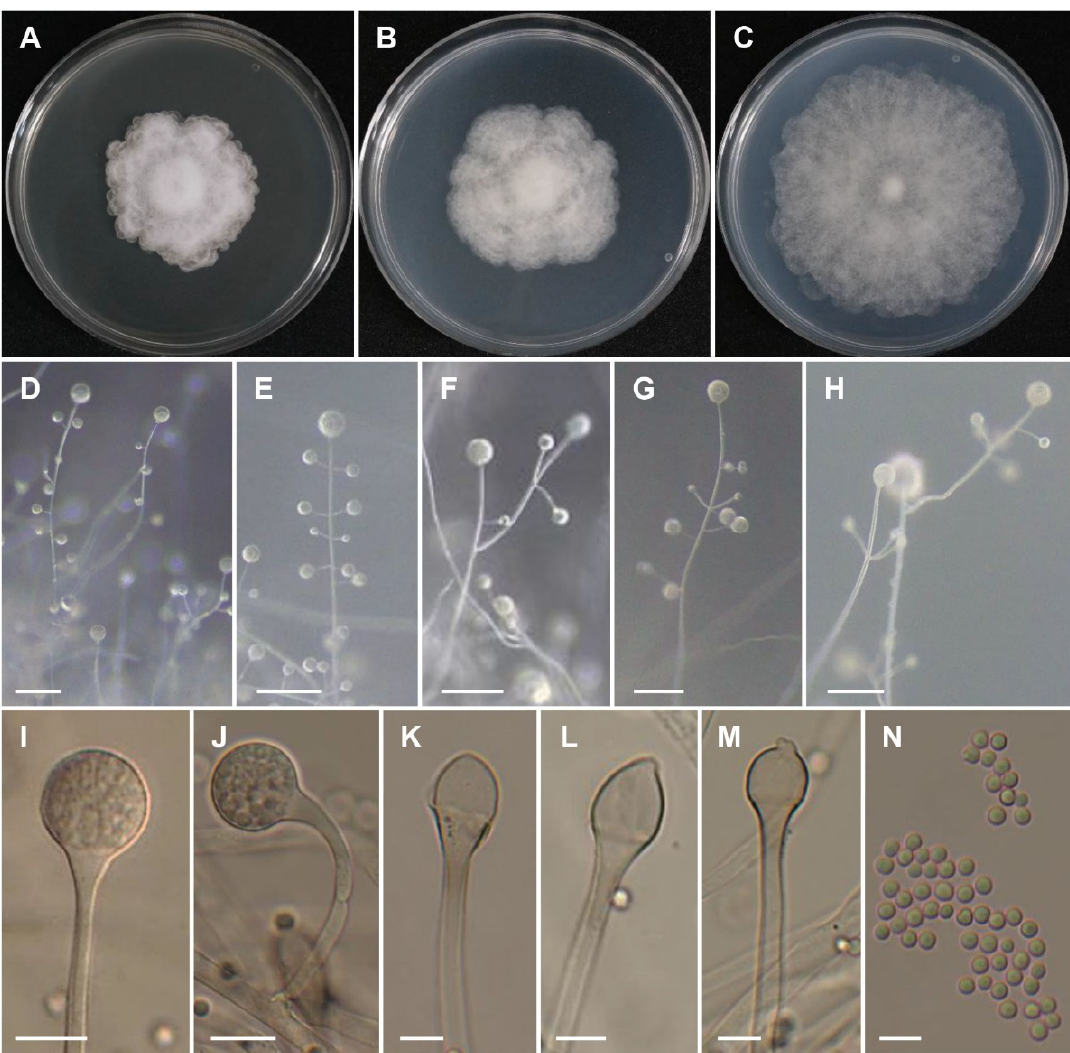
Figure 2. Lichtheimia koreana (CNUFC ISS71). ( A ) colony on MEA; ( B ) colony on PDA; ( C ) colony on SMA; ( D – H ) branched sporangiophores with sporangia observed under stereomicroscope; ( I ) mature sporangium; ( J ) circinate sporangiophore with sporangium; ( K – M ) columellae with or without projection; ( N ) sporangiospores. Scale bars: D–H = 100 μ m, I–J = 20 μ m, K–N = 10 μ m.